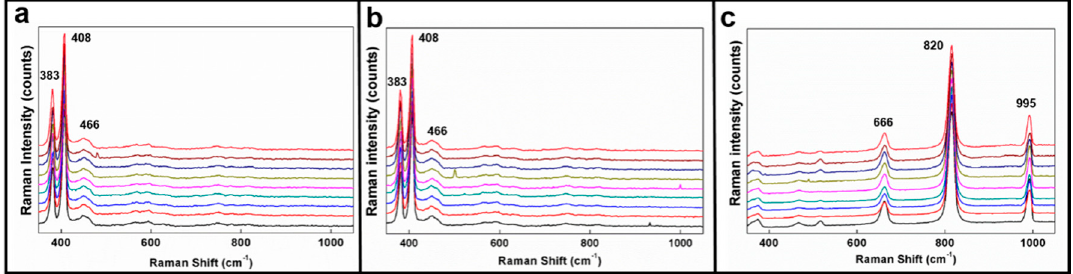
Figure 3. Nine-point Raman analysis of homogeneity for ( a ) IF-MoS 2 NP-; ( b ) 2H-MoS 2 NP-; and ( c ) MoO 3 NP-added HPMC.